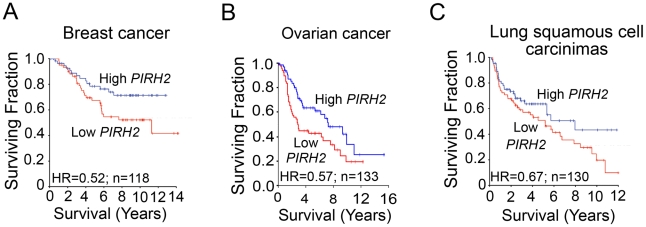
Downregulation of PIRH2 Associates with Short-Term Survival of Patients with Breast Cancer, Ovarian Cancer, or Squamous Cell Carcinomas of the Lung.Datasets of cancer patients at different stages were used to test for any association between PIRH2 mRNA levels and patient outcome. PIRH2 mRNA expression is significantly down-regulated in short-term survival breast cancer patients [27] (P = 0.049, HR = 0.52, 95% CI 0.27–1.0, n = 118) (A), in short-term survival ovarian cancer patients [28] (P = 0.02; HR = 0.36–0.92) (B) and short-term survival patients with squamous cell carcinomas of the lung [31] (P = 0.11, HR = 0.67, 95% CI 0.41–1.1, n = 130) (C). HR: Hazard ratio.